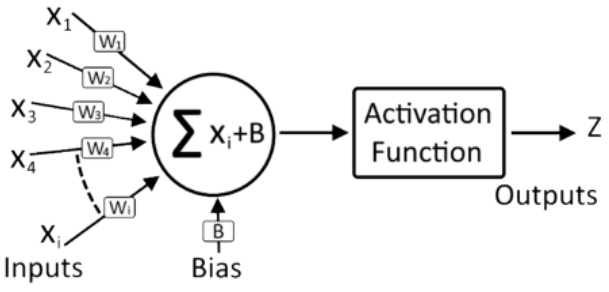
Figure 5. Computational neuron model.